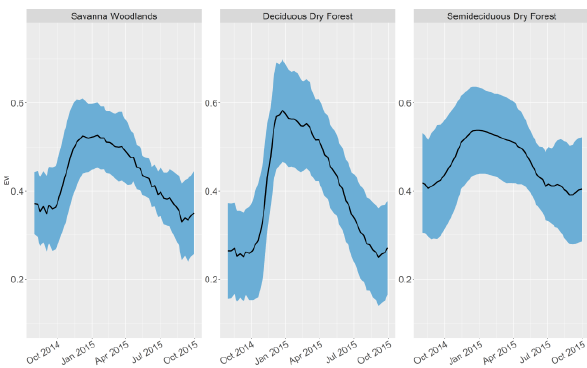
Figure 5. Averaged EVI phenological profiles for each class in the season 2014 – 2015 (black lines), with their respective standard deviations (blue margins)